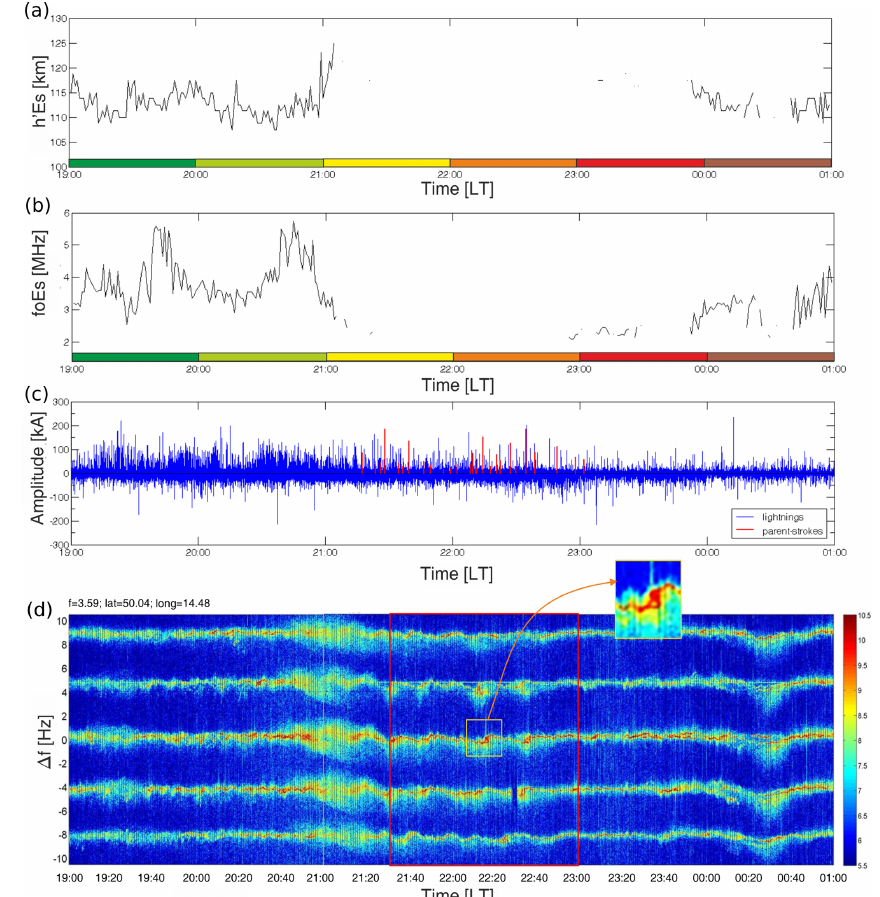
Figure 15. The reduction and disappearance of the ongoing Es layer activity detected at Pruhonice during part of the time of a traversing thunderstorm. Temporal variations of (a) h’ES, (b) foEs, (c) peak current and polarity of CG strokes within 200km from Pruhonice with the sprite-parent discharges shown in red, and (d) the continuous Doppler sounding spectrogram. Doppler-shifted signals in the time interval 21:30–23:00LT inside the red rectangular form S-like traces (as is magnified in the inset), which are attributed to a wave-like modulation caused by gravity waves. (Re-printed from Barta et al., 2017, Fig.